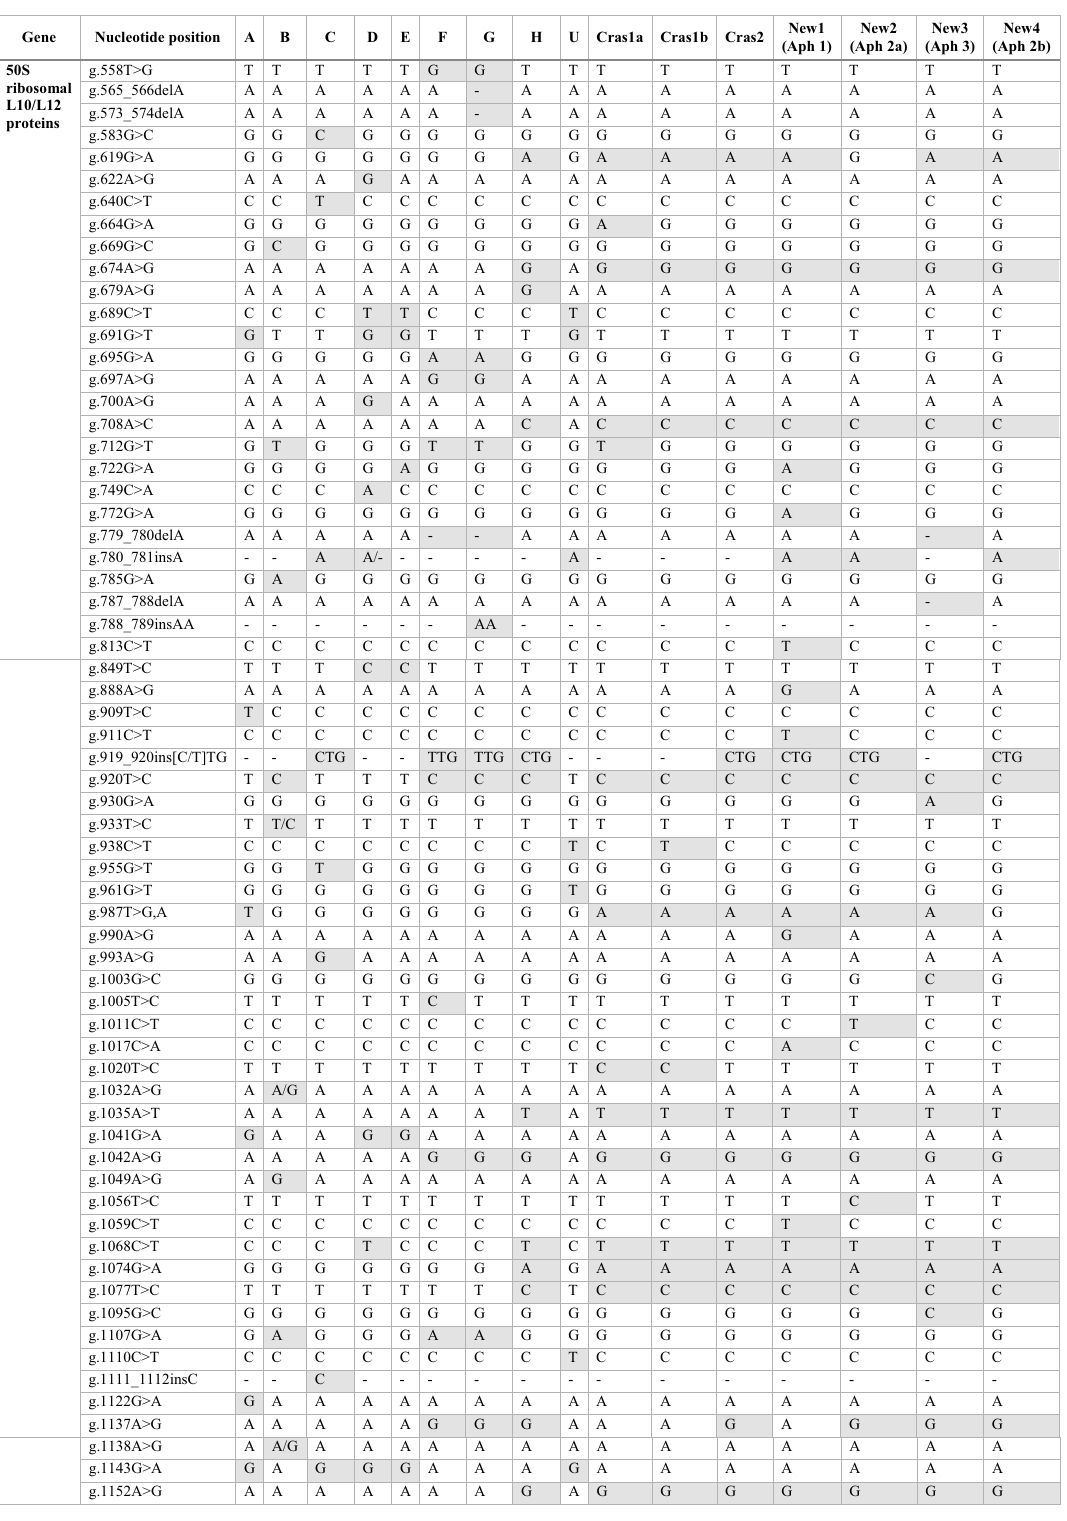
Table 2. Single nucleotide polymorphism comparison in the 50S ribosomal L10 and L12 protein genes between ‘ Ca. L. solanacearum’ haplotypes A, B, C, D, E, F, G, H, U, Cras1a, Cras1b, Cras2, and the four new sequence profiles, New1 (ON569100; haplotype Aph1), New2 (ON569101; haplotype Aph2a), New3 (ON569102; haplotype Aph3), and New4 (ON569103; haplotype